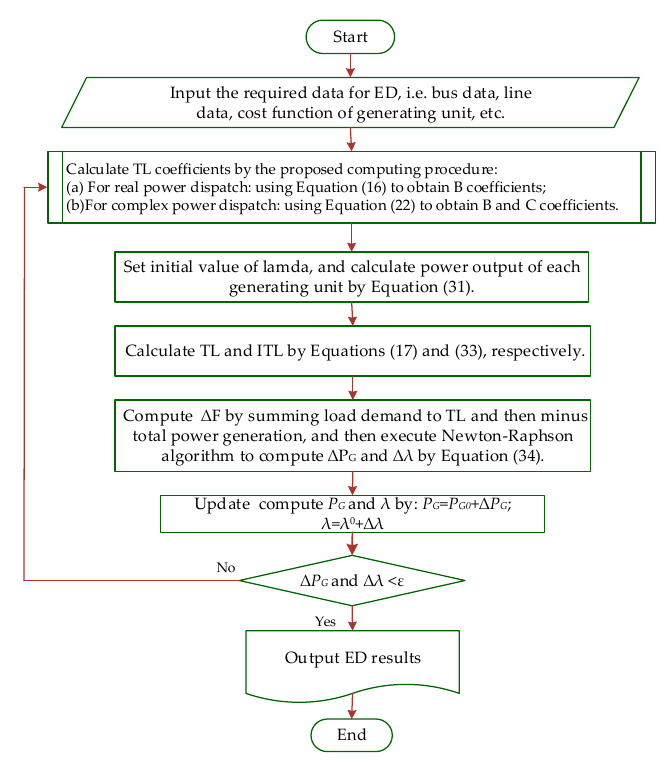
Figure 3. Solution flow chart of the new loss coefficients-based ED in power systems.